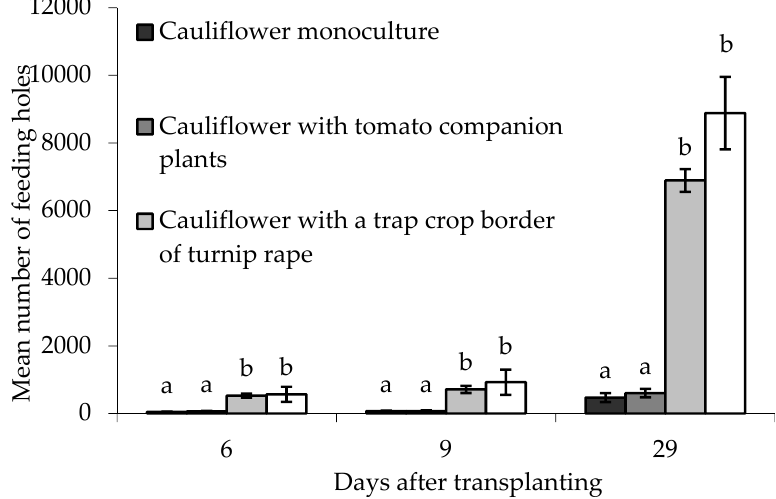
Figure 7. Number of flea beetle feeding holes (mean ± SE) on leaves of eight border plants grown under different treatments at different times after transplanting. n = 3 for all means. Means with different letters (a–b) denote significant differences between treatments on any given sampling occasion.